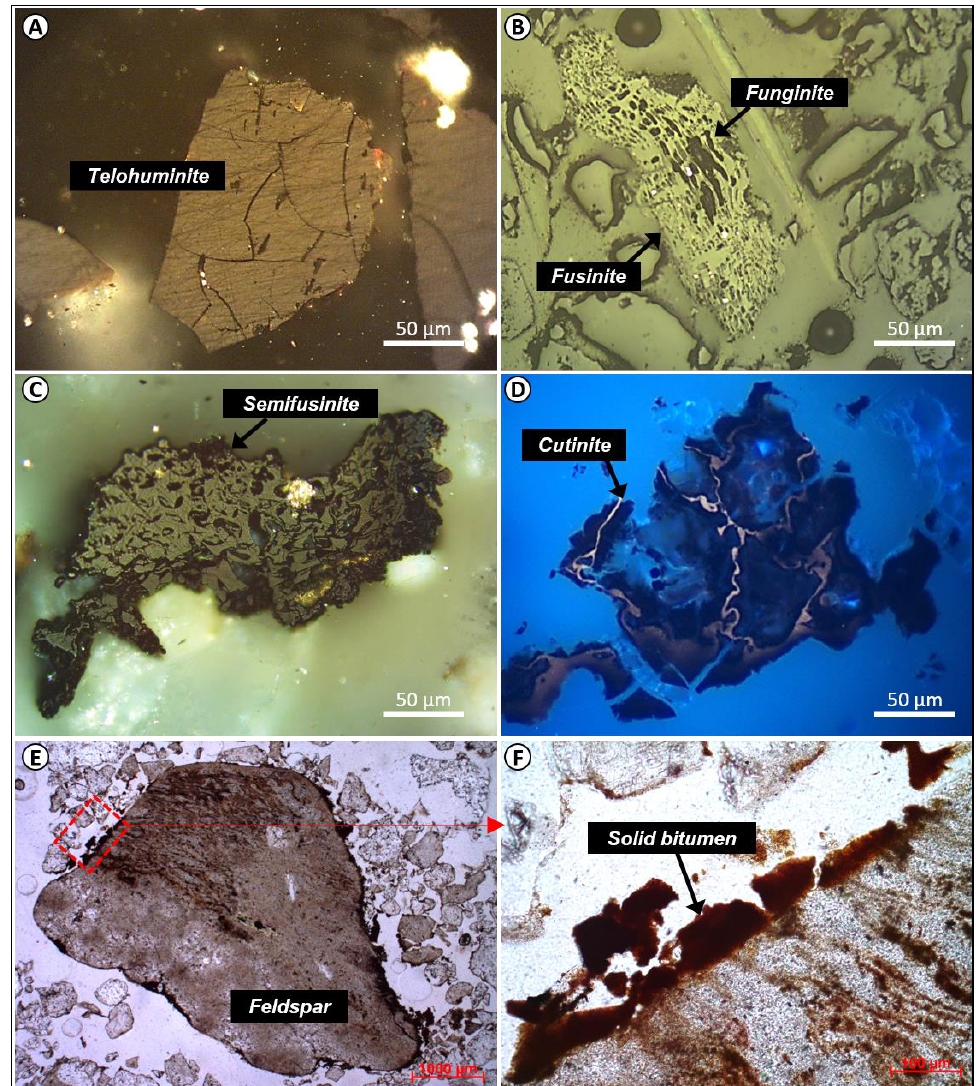
Figure 3. Presentation of the organic particles (macerals) recognized in the Zoovch Ovoo reservoir. ( A – C ) Polished blocks under oil-immersion indicating telohuminite, fusinite, funginite and finally semifusinite. ( D ) Fluorescence mode on thin section indicating cutinite. ( E , F ) Plain light on thin section showing solid bitumen penetrating and concentrated along the rims and fractures of a porous feldspar.